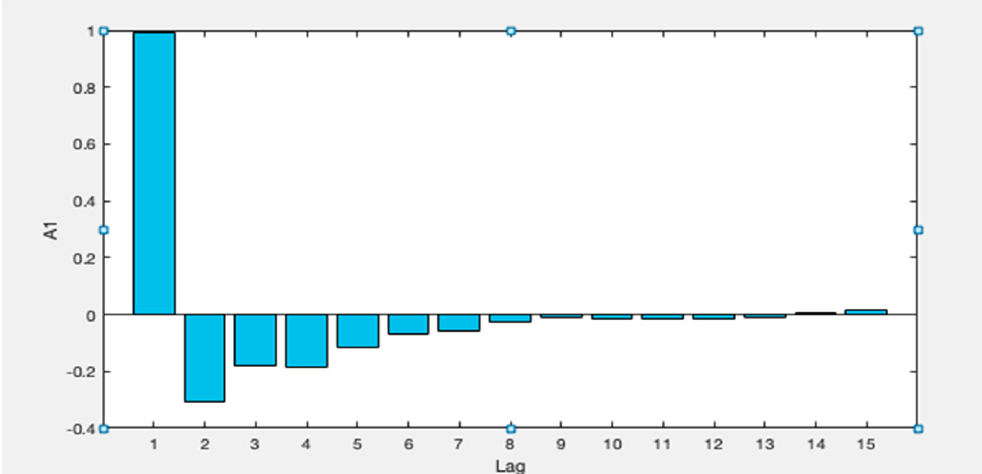
Figure 18. The PACF results of A1 by EWT of “front flat line 95.”